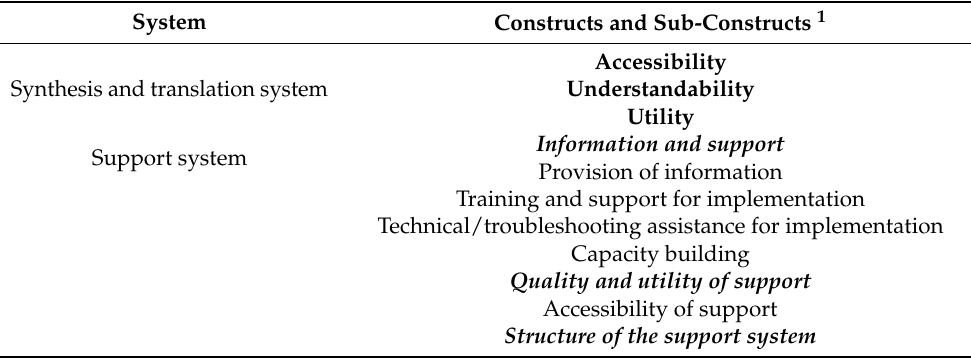
Table 1. Adapted Interactive Systems